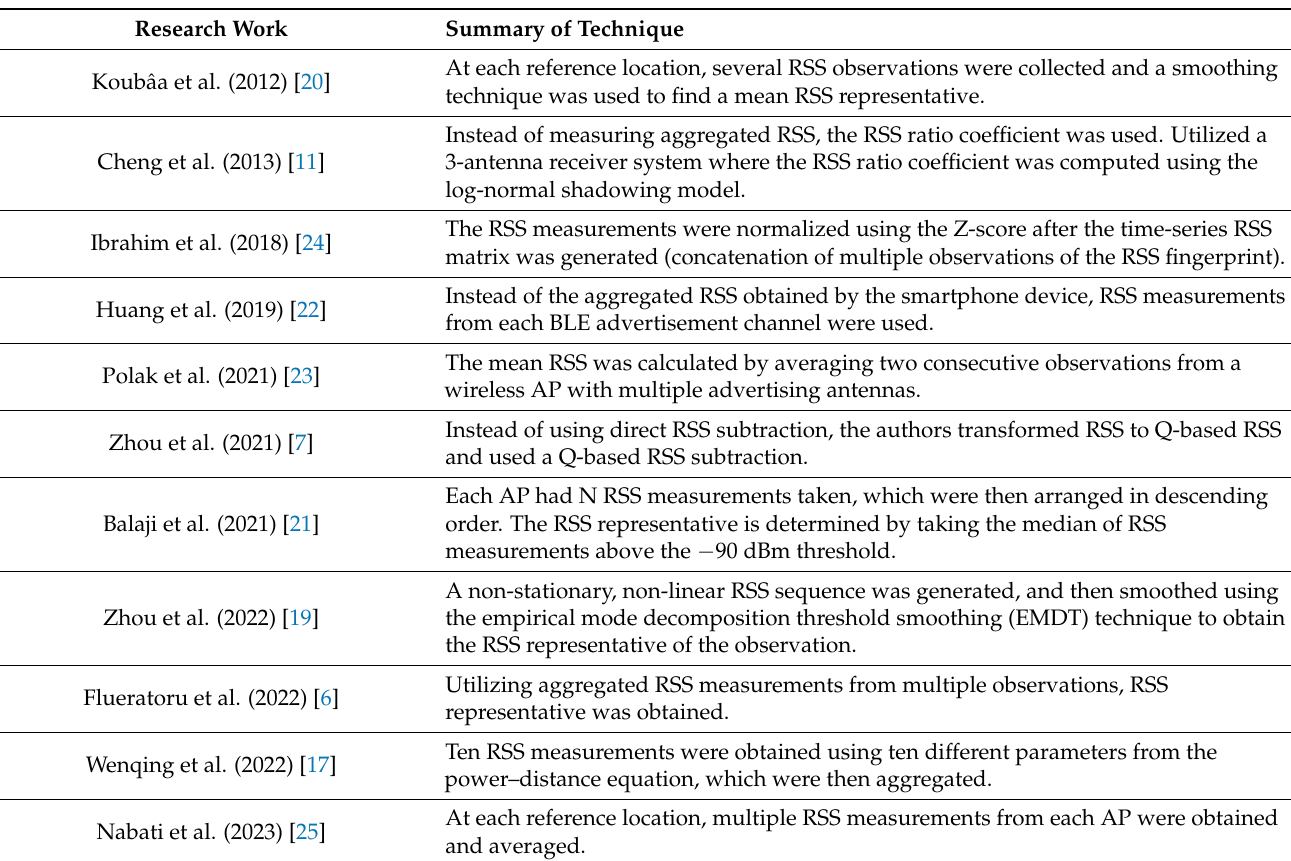
Table 1. A summary of techniques for dealing with RSS